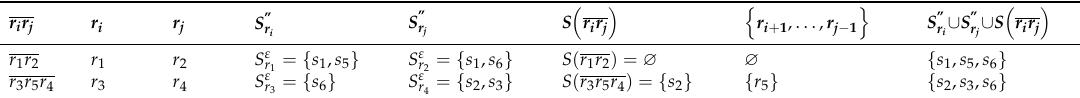
Table 3. Computation of R (cid:46)(cid:47) ε S using the naive EDISON algorithm.